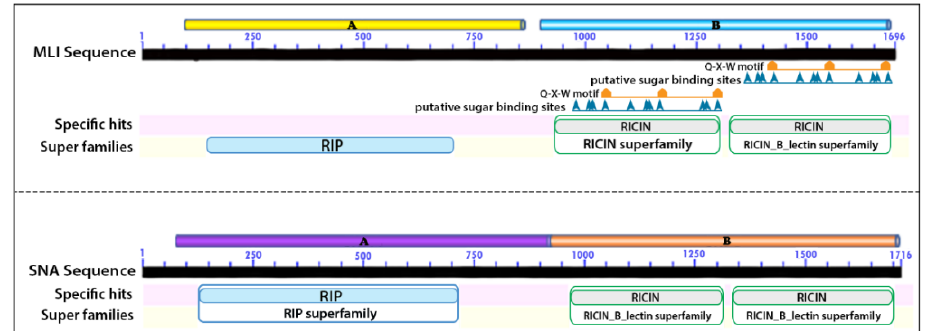
Figure 1. Analysis map of MLI and SNA coding sequences.